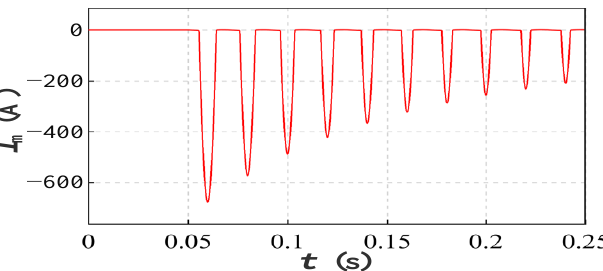
former closing at 0°.